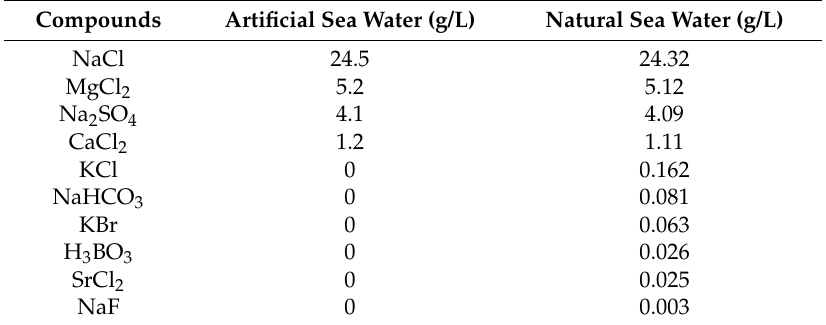
Table 4. Comparison of the compositions of artificial sea water and natural sea